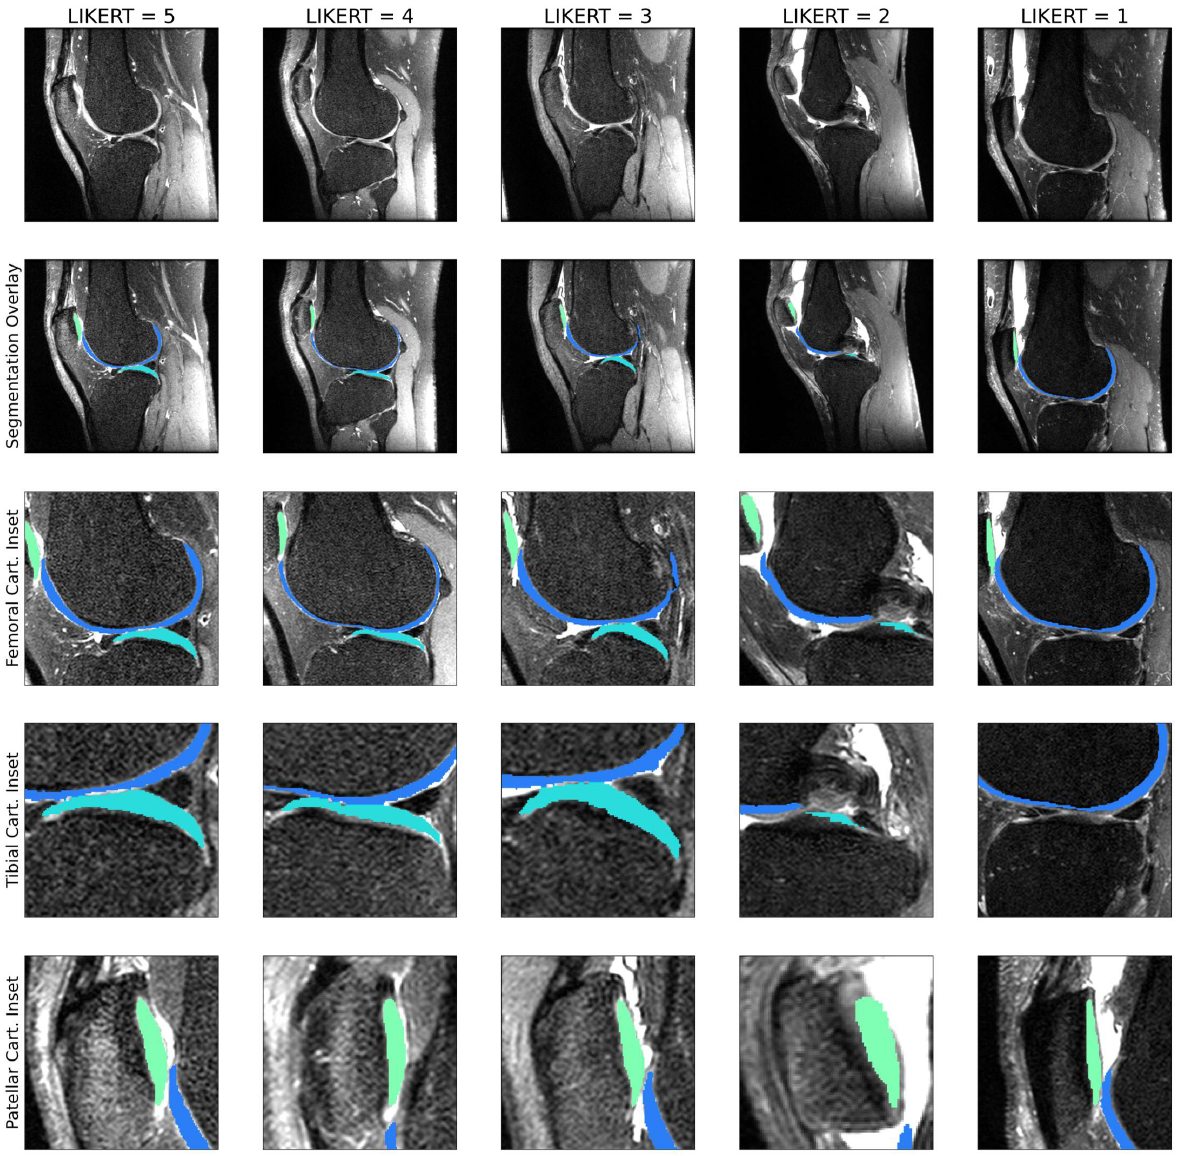
Figure 4. 1–5 LIKERT cartilage segmentation scores overlaid on ground truth knee scans. In this example, the LIKERT of 5 indicates human-like segmentation; the LIKERT of 4 shows a slight underestimation of patellar and tibial cartilage; the LIKERT of 3 is assigned due to minor underestimation of patellar and tibial cartilage, with soft tissue detected as femoral cartilage; the LIKERT of 2 is assigned due to missing mask areas for patellar and tibial cartilage, with femoral cartilage overestimation; the LIKERT of 1 is missing a tibial cartilage mask.